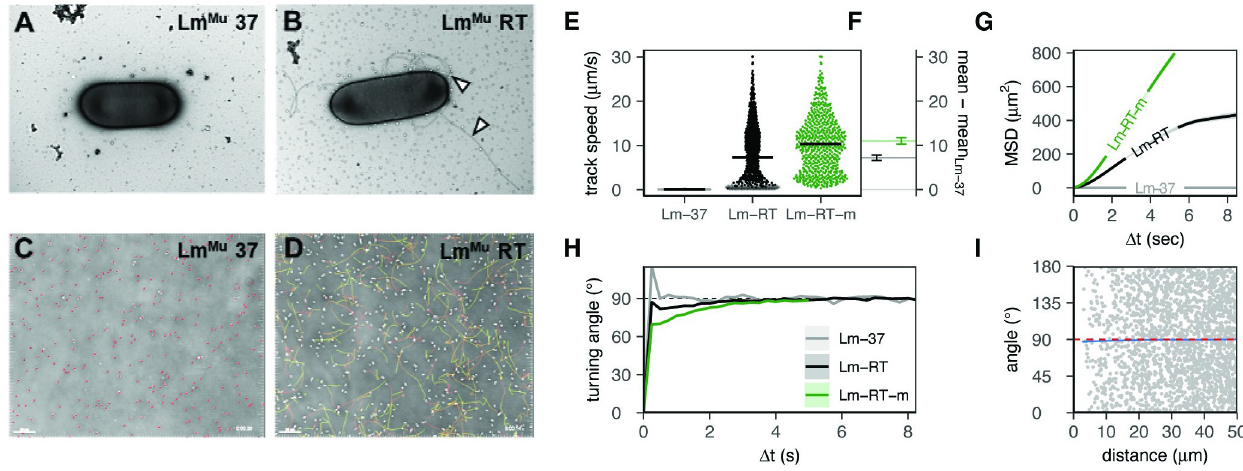
Fig 1. Murinized Listeria (Lm Mu ) grown at room temperature is flagellated and highly motile. A: electron microscopy shows that Lm cultured at 37˚C (Lm-37) is non-flagellated, while B: Lm grown at 23˚C (Lm-RT) develops extensive peritrichous flagella (white arrows). Scale bar = 1 μ m. C: video microscopy shows that Lm-37 is non-motile in vitro (white cells, time encoded tracks) in contrast to D: Lm-RT which is highly motile (white cells, time encoded tracks). Scale bar = 30 μ m. This difference in motility is supported by E: the mean speed per bacterium (with Lm-RT-m a filtered, “motile” subset; see S2 Fig), and F: the bootstrapped 99% confidence interval (CI) of the increase in population mean speed for Lm-RT(-m) versus Lm-37 (bootstrap N = 10000). The increased motility of Lm-RT(-m) also yields higher G: mean squared displacements (MSD ± standard error, SE) for time intervals Δ t, and lower H: turning angles (mean ± SE); mean angles < 90˚ indicate persistent motion over interval Δ t. Lm-RT-m cells move independently from each other, as shown by I: angles versus distance of single “steps” co-occurring at the same time (gray points reflect 2% of data to avoid overplotting). The mean angle (blue line) is 90˚ if bacteria move independently, with deviations indicating crowding effects (if limited to small distances) or global directionality (if systematic).